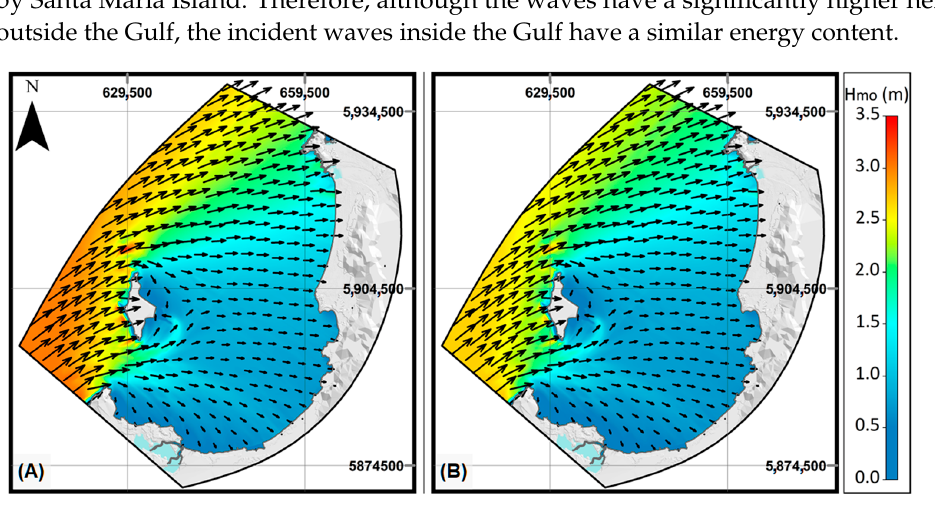
Figure 8. Predominant wave propagation in the Arauco Gulf: ( A ) winter, ( B ) summer. The dominant wave characteristics in deep water for summer and winter scenarios are shown in Table 3. Arrows illustrate the peak wave direction.